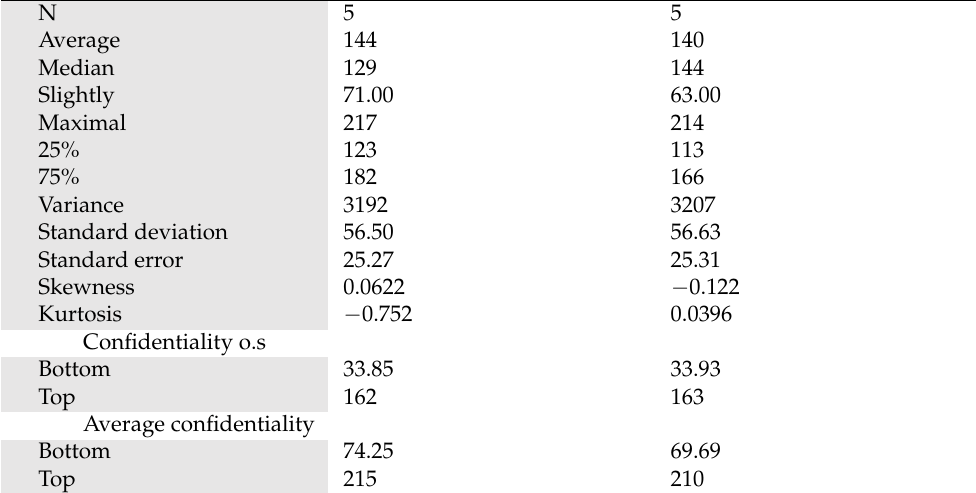
Table 2. Result analysis (Figures 18 and 19).